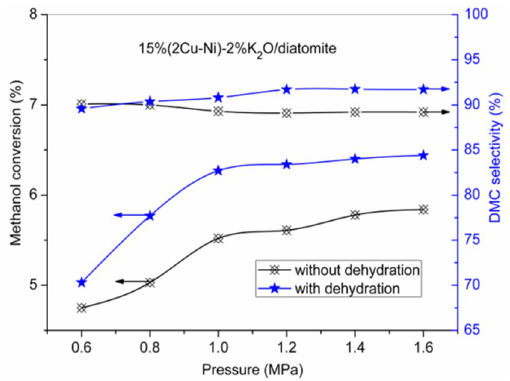
Figure 7 . The effect of pressure on performance of catalyst with or without dehydration .